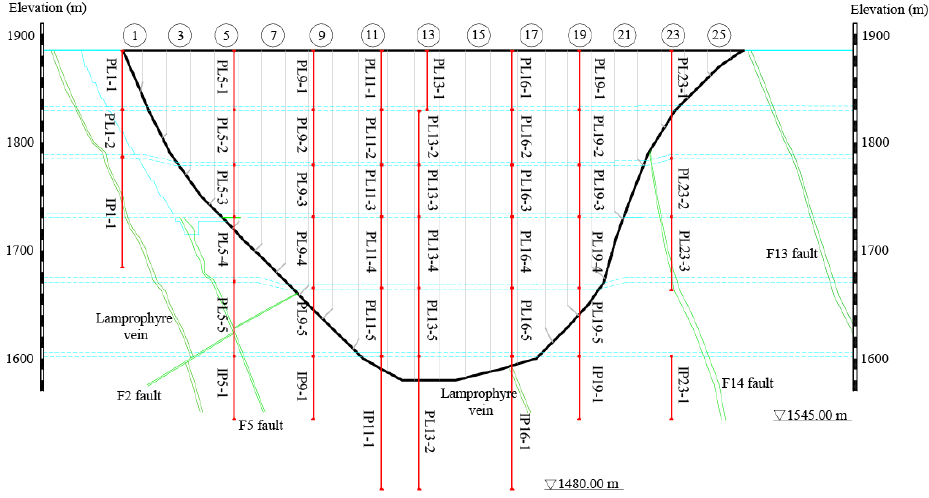
Figure 7. Layout of the pendulum system of Jinping-I arch dam.